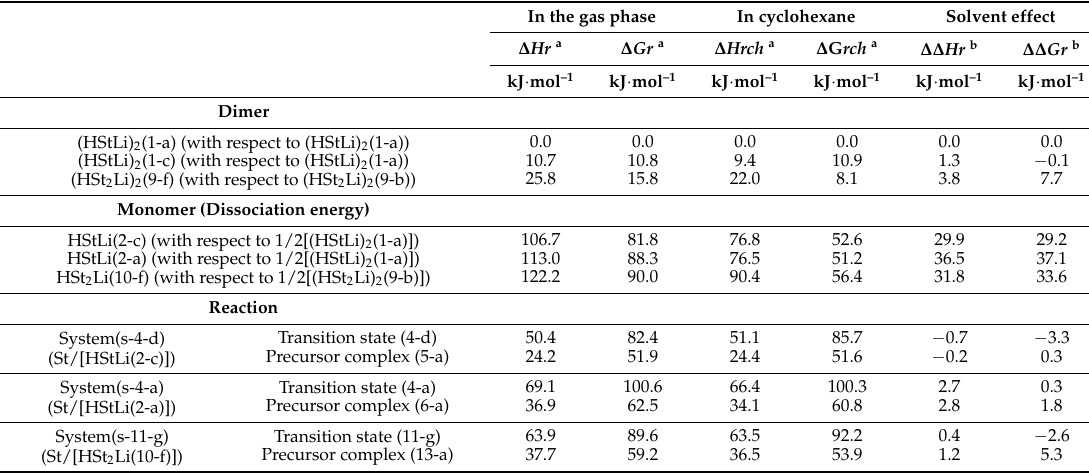
Table 2. Energetic effect of the cyclohexane environment on the important structures discussed in the gas phase sections. In the gas phase In cyclohexane Solvent effect ∆ Hr a ∆ Gr a ∆ Hrch